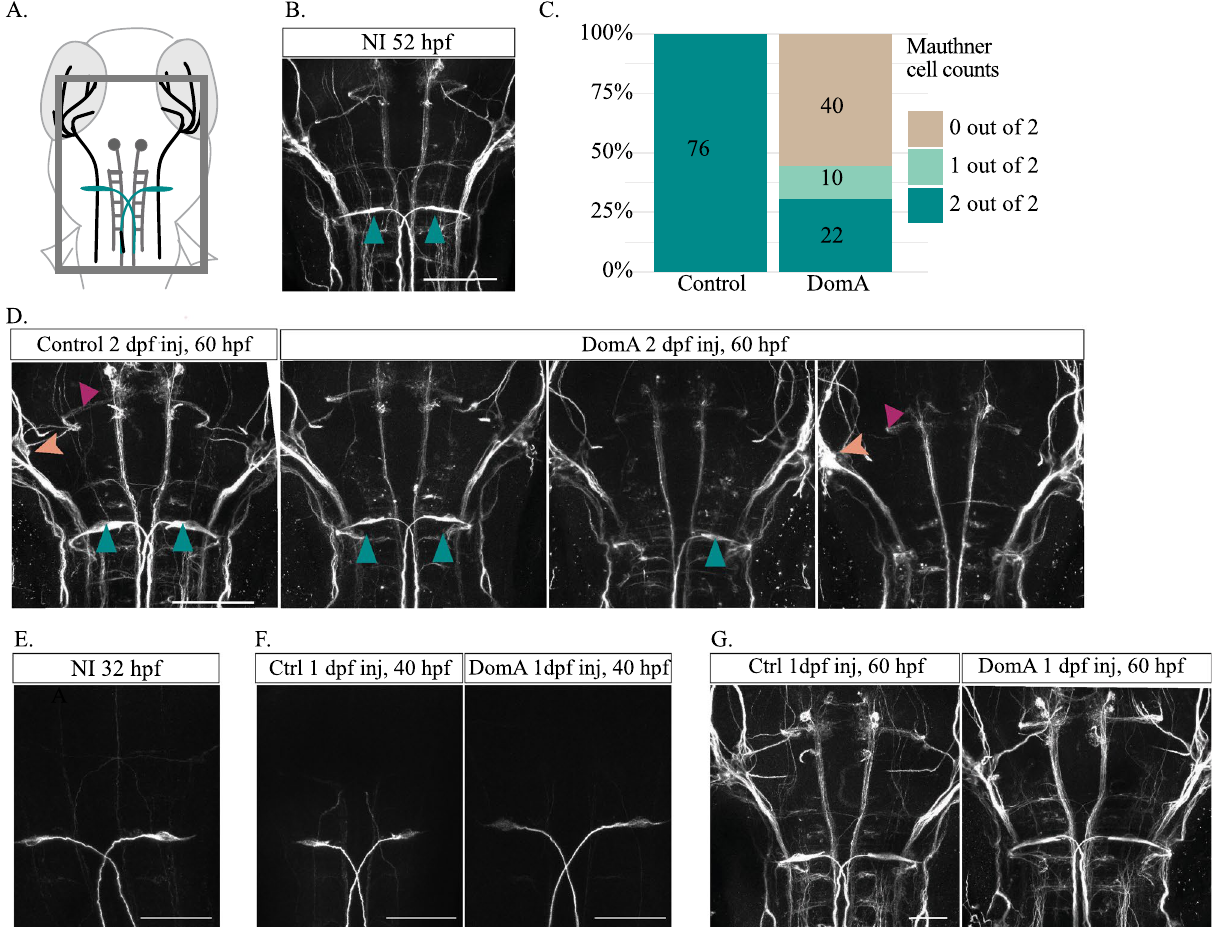
Figure 4. Exposure to DomA at 2 dpf (but not 1 dpf) leads to the loss of the Mauthner neuron prior to myelination. ( A ) Diagram of 2.5 dpf embryos that were dorsally mounted and immunostained with anti-3A10. The rectangle delineates the approximate area that was imaged. Mauthner cells are labeled in teal. ( B ) 3A10 immunostaining of approximately 52-hpf, non-injected (NI) embryos confirmed that all the major reticulospinal neurons are present by the 2 dpf (48–53 hpf) injection period (n = 26). Teal arrows label Mauthner cells. Scale bar = 100 μm. ( C ) Percentage of embryos exposed to DomA (2 dpf) or vehicle that had 0, 1, or 2 Mauthner cells after being stained for anti-3A10 at approximately 60 hpf. Numbers of larvae with each phenotype are listed within each bar. Data were aggregated from four trials. See Supplemental Fig. 3 for individual trial data. ( D ) 3A10 immunostaining of embryos that were exposed to DomA at 2 dpf then processed approximately 8 h post exposure (60 hpf). Teal arrows label Mauthner cells, peach arrows label the anterior lateral line, and magenta arrows label the medial longitudinal fasciculus. Scale bar = 100 μm. ( E ) 3A10 immunostaining of 32-hpf, non-injected (NI) embryos confirmed that all the major reticulospinal neurons are present by 1 dpf injection period (n = 10). Scale bar = 50 μm. ( F ) 3A10 immunostaining of embryos that were exposed to DomA at 1 dpf (32 hpf), then processed approximately 8 h post exposure (40 hpf). Control embryos (n = 38); DomA exposed embryos (n = 38), with n = 37 fish with 2 Mauthner cells, and n = 1 with 1 Mauthner cell. Scale bar = 50 μm. ( G ) 3A10 immunostaining of embryos that were exposed to DomA at 1 dpf (32 hpf), then processed at 60 hpf. Control embryos (n = 35), DomA exposed embryos (n = 41). All control and DomA- exposed fish had 2 Mauthner cells. Scale bar = 50